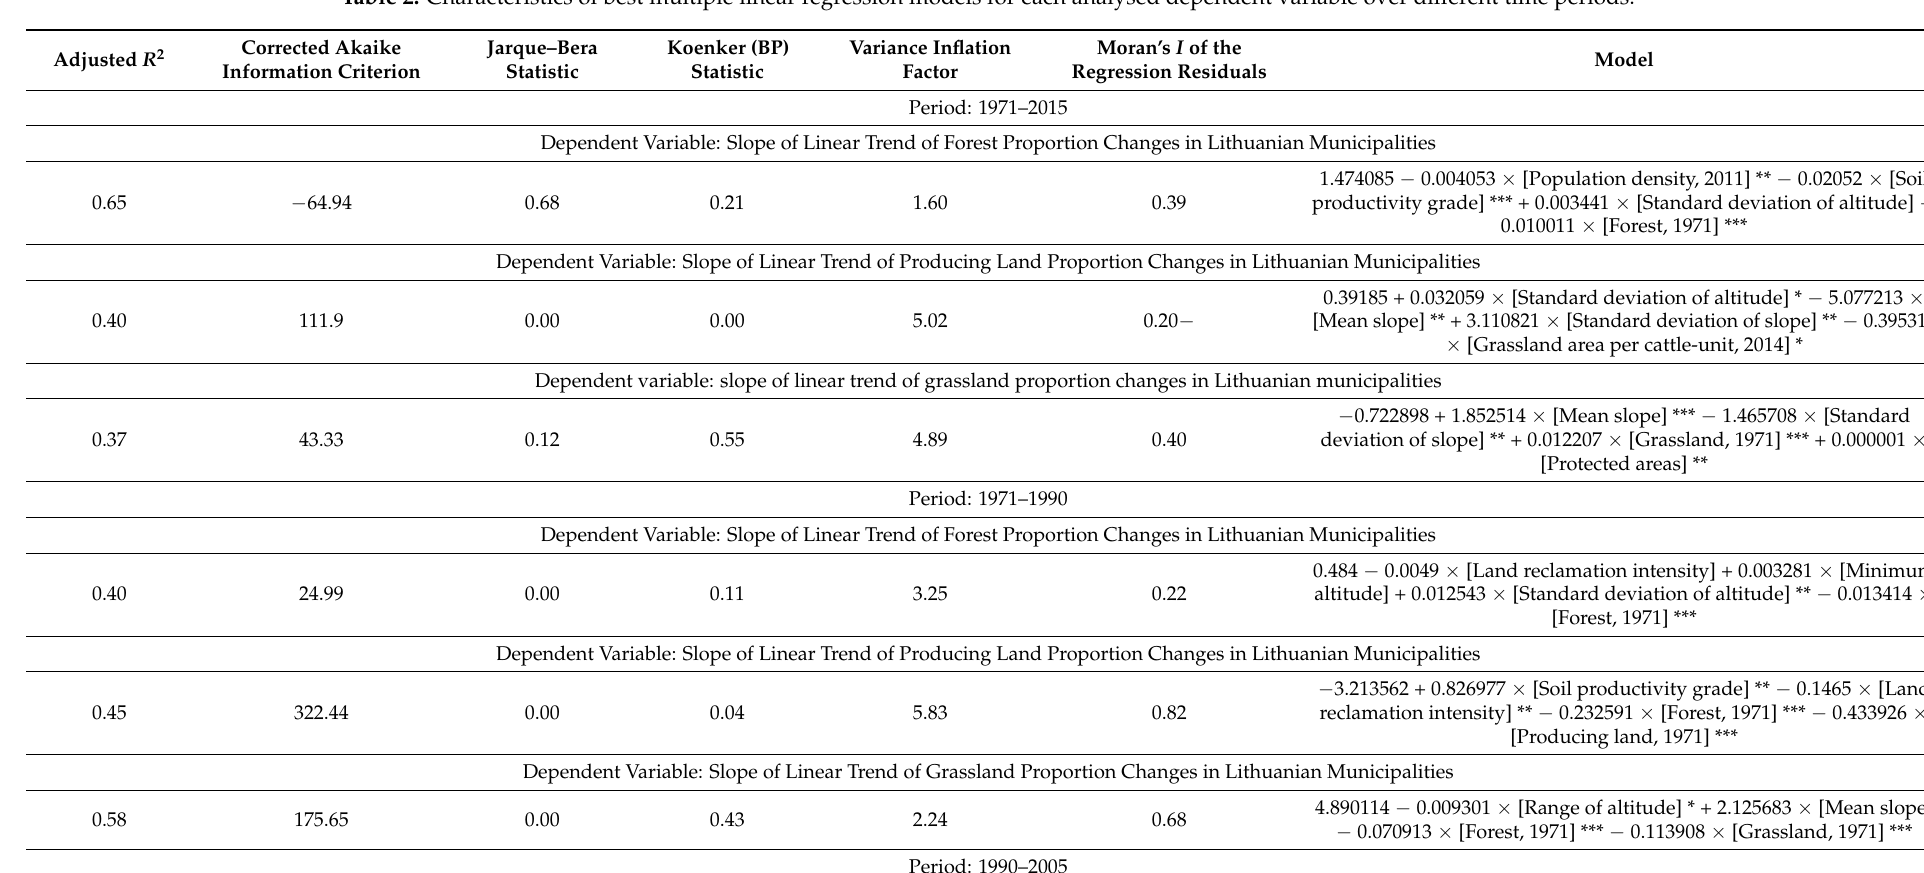
Table 2. Characteristics of best multiple linear regression models for each analysed dependent variable over different time